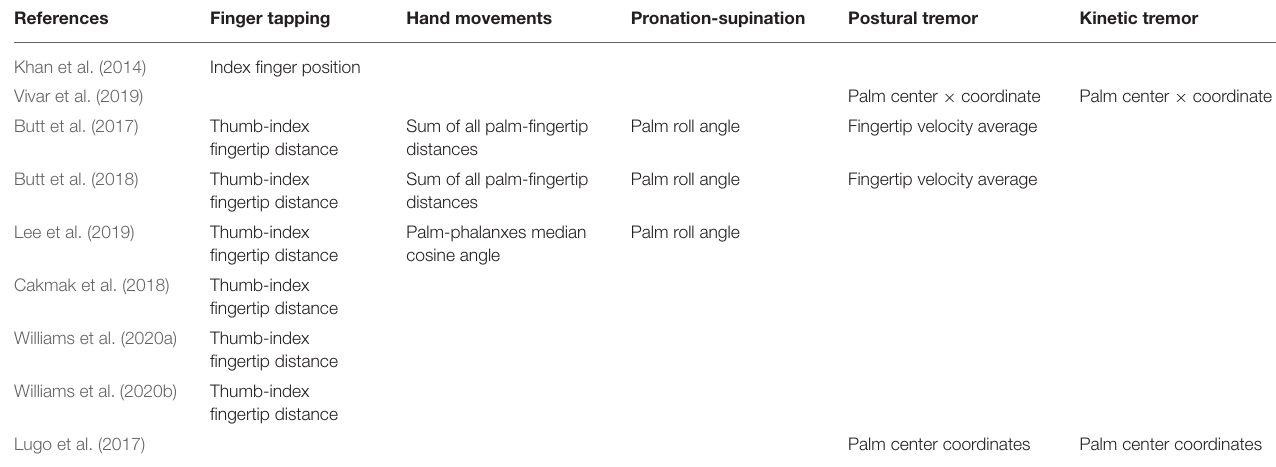
TABLE 1 | Study tasks and signal of